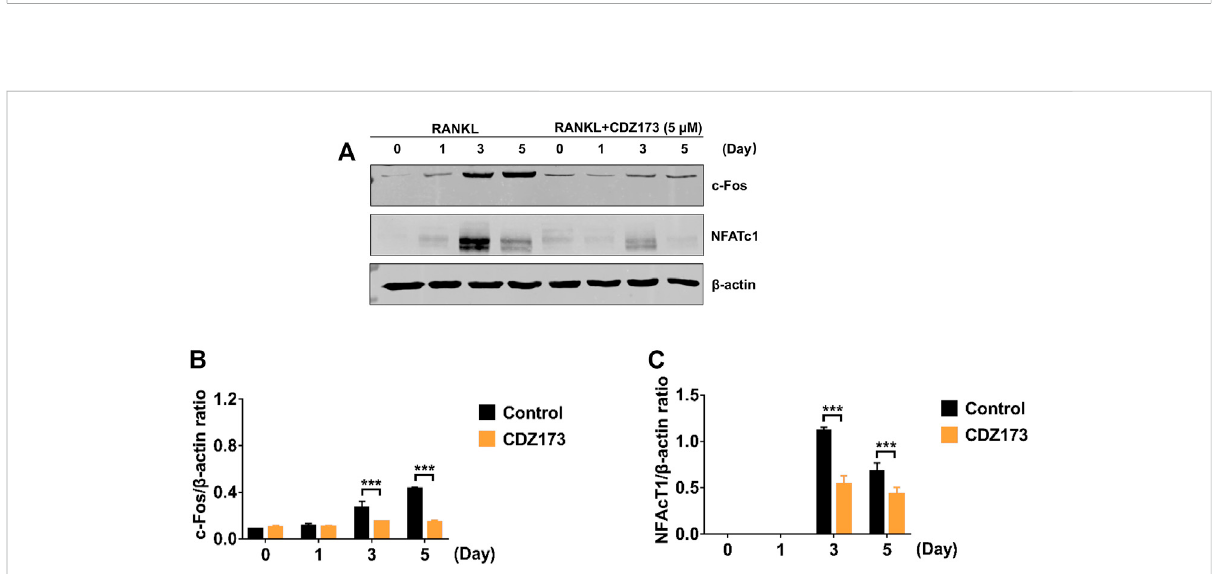
FIGURE 8 CDZ173 inhibited RANKL induced C-fos and NFATc1 transcriptional activity. (A) BMMs cultured with M-CSF(30 ng/ml) and RANKL (30 ng/ml) absence or presence of 5 μ M CDZ173 for 1, 3 or 5 days were lysed and total cellular protein extracts were subjected to western blot analysis using speci fi c antibodies to NFATc1, c-Fos and β -actin. The relative densitometry of protein bands for (B) c-Fos and (C) NFATc1 against β -actin were quanti fi ed using ImageJ (n = 3) (*** p <